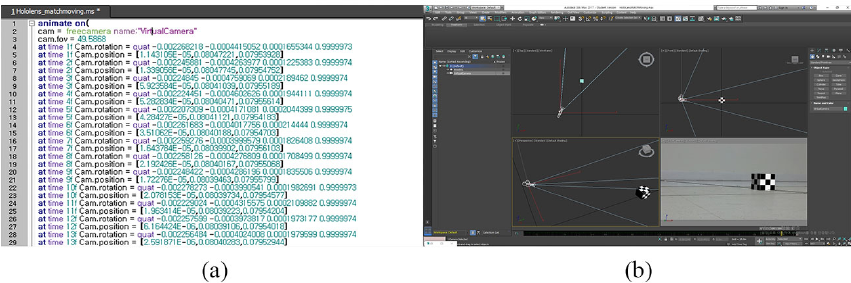
Figure 5. Max script generated from HoloLens and 3ds Max program. Synchronization of unit and coordinator system is required for using HoloLens data to 3ds Max. ( a ) Max script; ( b ) 3ds